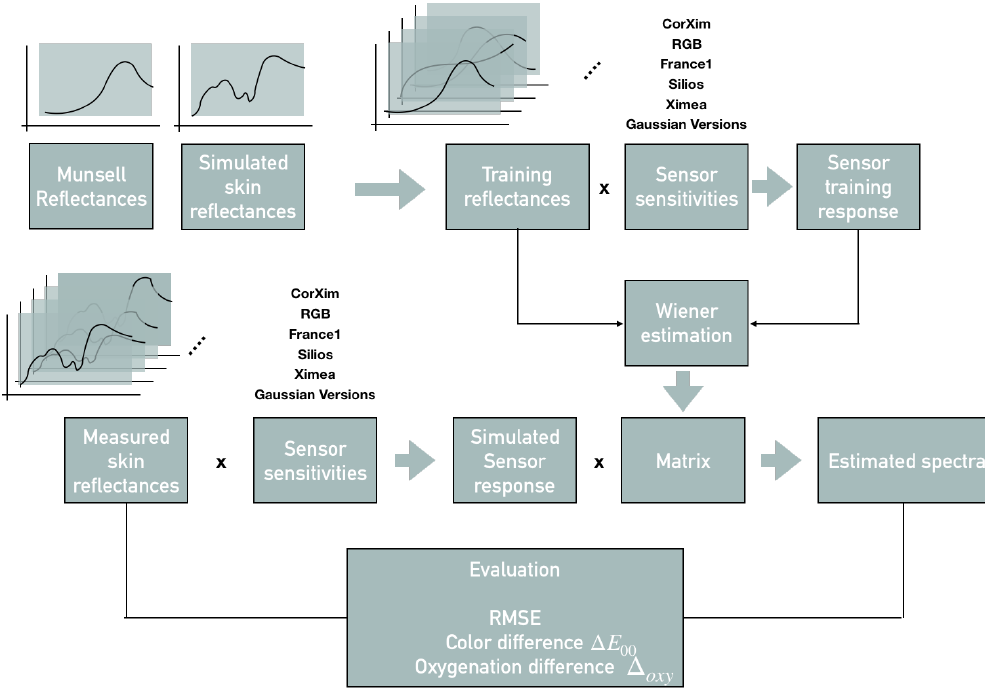
Figure 1. Framework, including training set, testing set, sensor sensitivities, reconstructed spectra and the evaluation according to RMSE, ∆ E 00 , ∆ Oxy